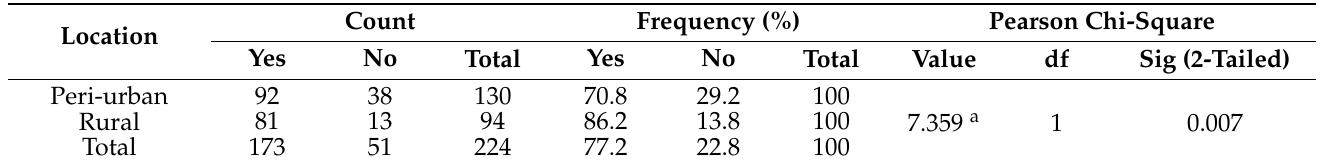
Table 5. Locational scenarios of land tenure dispute resolution.